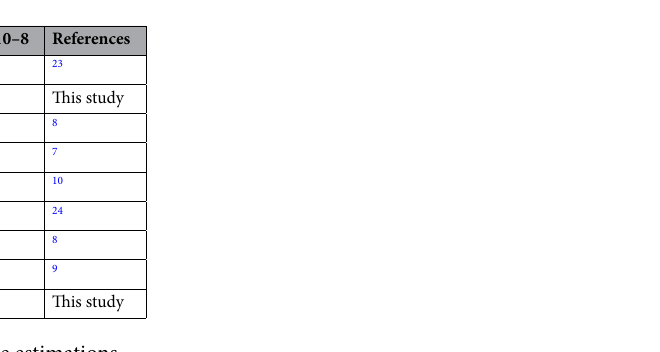
Table 2. MtDNA evolutionary rate